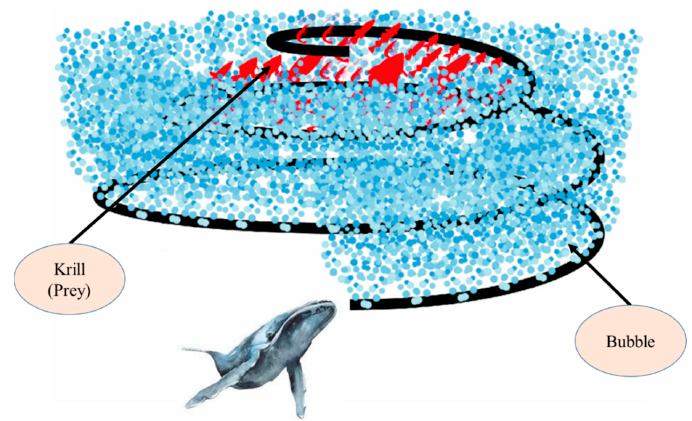
Figure 4. The humpback whales bubble-net feeding.